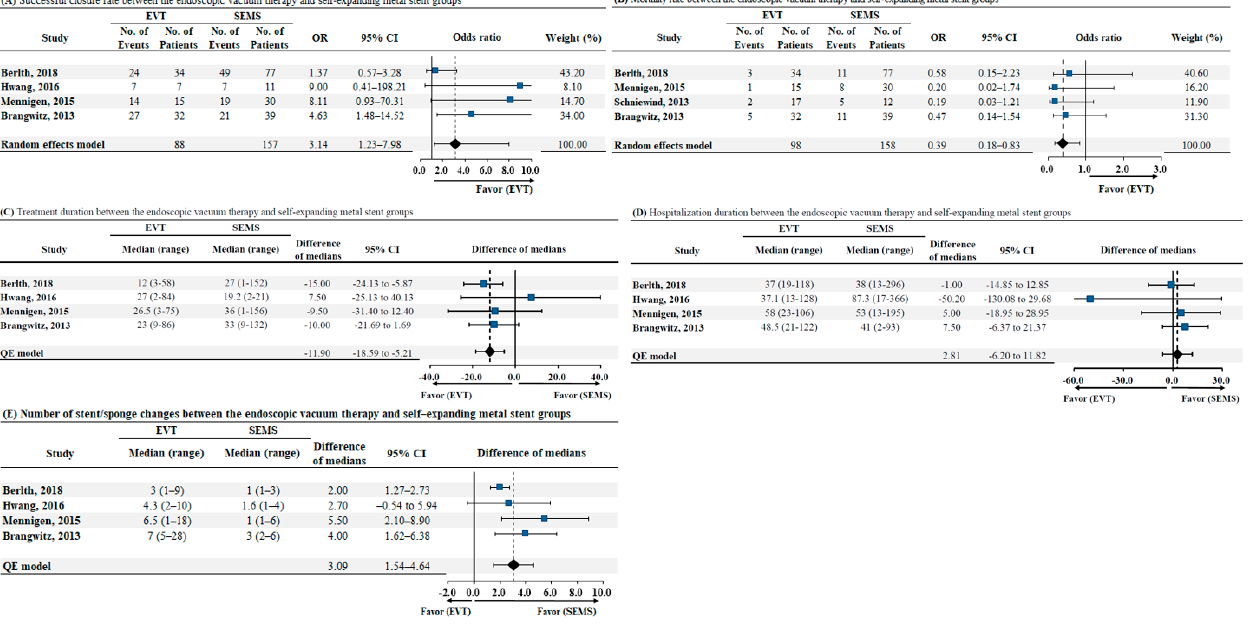
Figure 5. ( A ) Successful closure rate between endoscopic vacuum therapy and self-expanding metal stent groups, ( B ) Mortality rate between endoscopic vacuum therapy and self-expanding metal stent groups, ( C ) Treatment duration between endoscopic vacuum therapy and self-expanding metal stent groups, ( D ) Hospitalization duration between endoscopic vacuum therapy and self-expanding metal stent groups, ( E ) Number of stent/sponge changes between endoscopic vacuum therapy and self-expanding metal stent groups. Abbreviations: EVT, endoscopic vacuum therapy; SEMS self-expanding metal stent; No, number; OR, odds ratio; CI, confidence interval; QE, quantitative estimation.